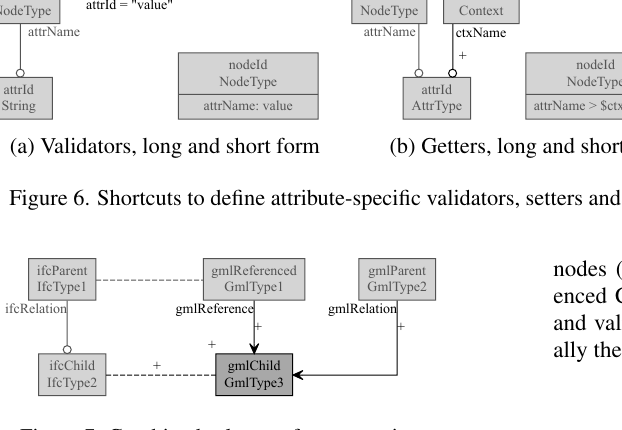
Figure 7. Combined rule type for